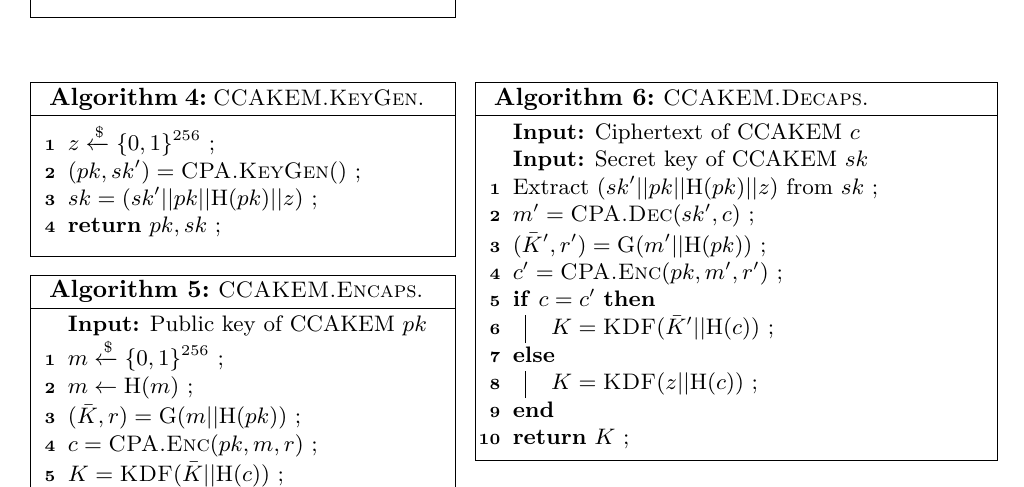
Algorithm 3: CPA.Dec .